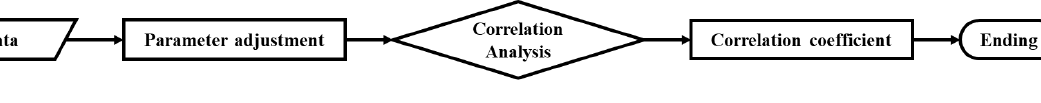
Figure 2. The flow chart of this